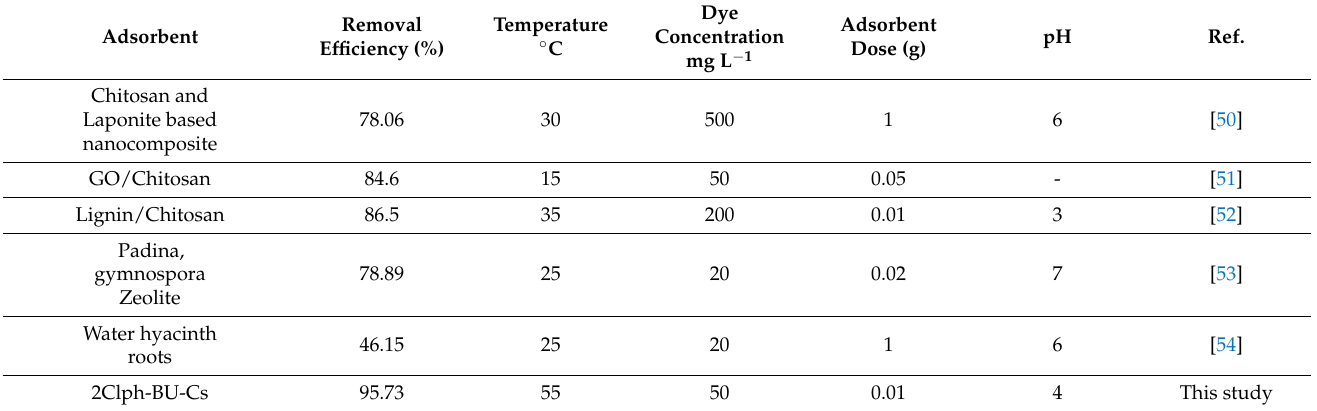
Table 5. Comparing 2Clph-BU-Cs with various adsorbents to remove CR